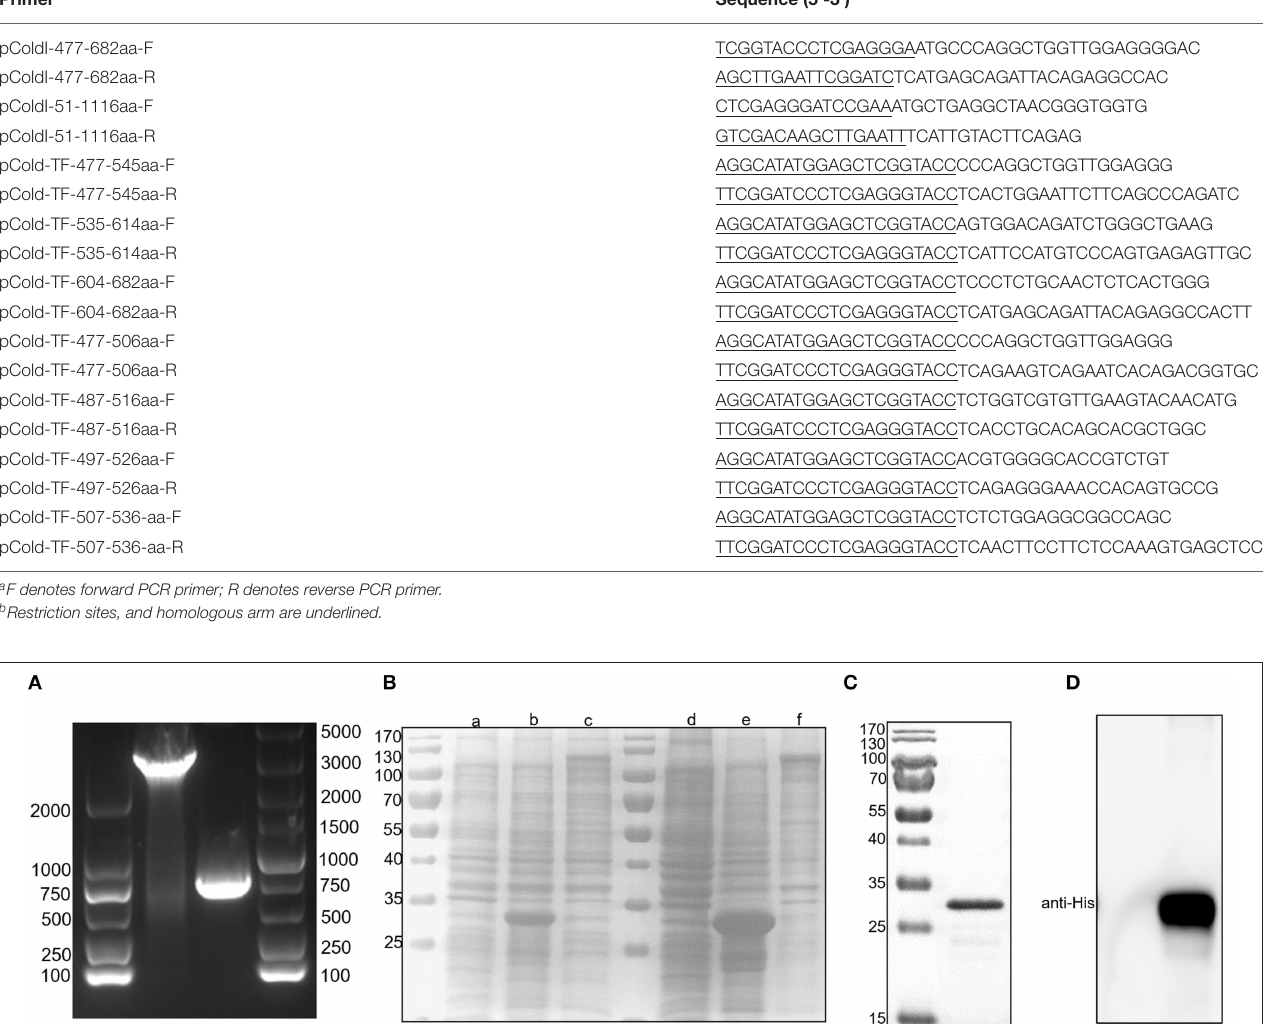
TABLE 1 | Primer for plasmids construction. Primer a Sequence (5 ′ -3 ′ ) b